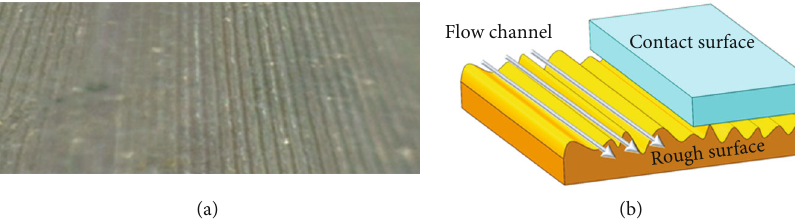
Figure 5: Schematic diagram of a liquid fl ow channel on the contact surface. (a) Scanning diagram of a valve seat metal surface. (b) Schematic diagram of a fl ow channel on the contact